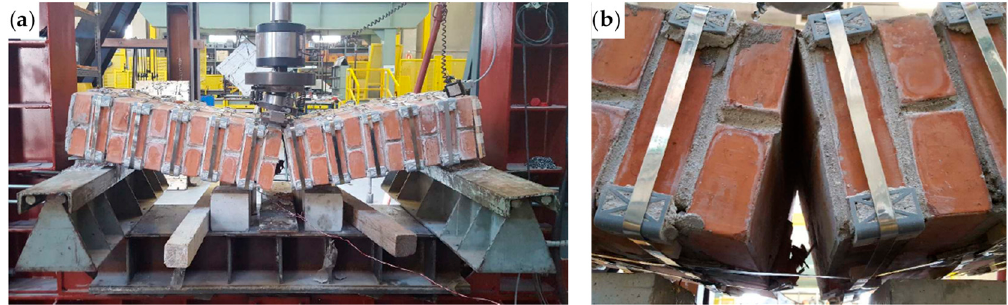
Figure 39. Specimen W1 shortly before the interruption of the test [1]: ( a ) disconnection mechanism and ( b ) detail of the disconnected cross-section (brick tear in the background).